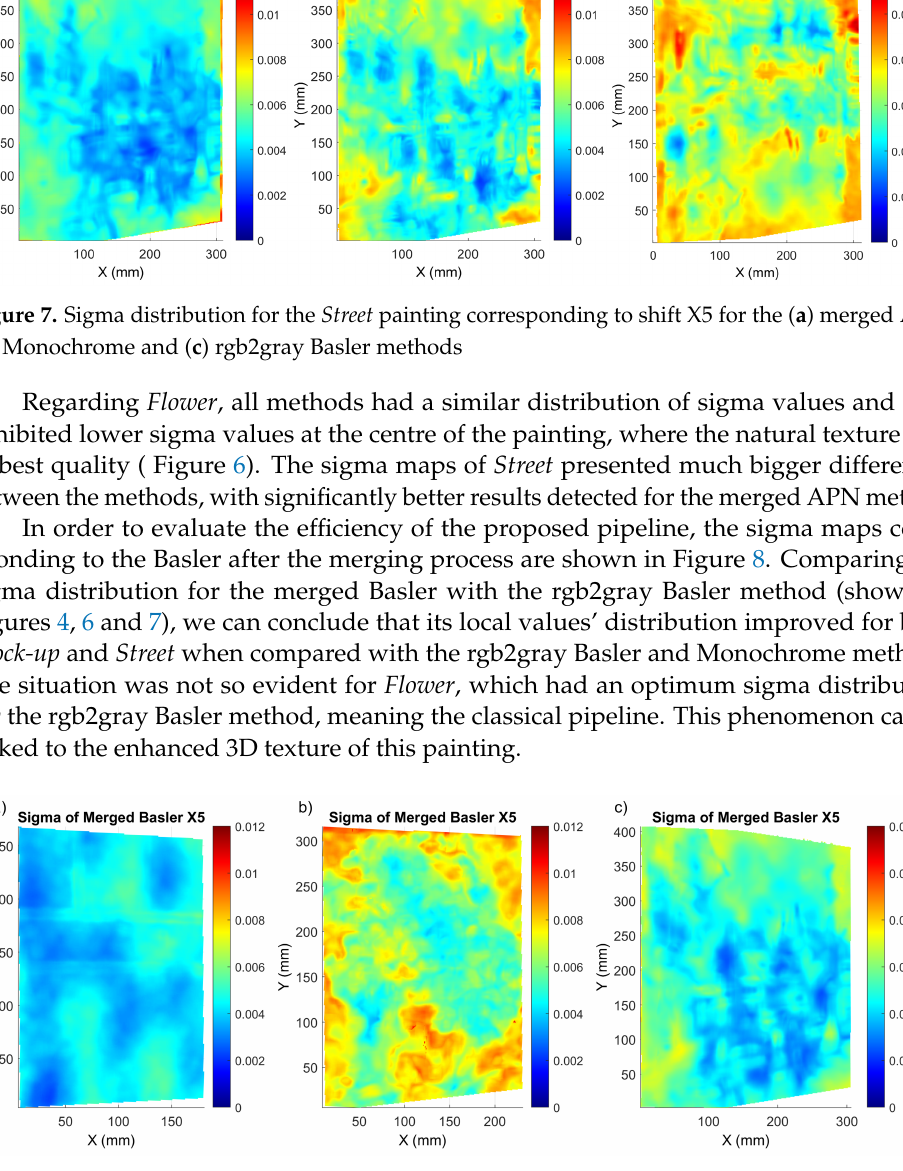
Figure 8. Sigma distribution for ( a ) Mock-up , ( b ) Flower and ( c ) Street corresponding to shift X5 after the merged Basler